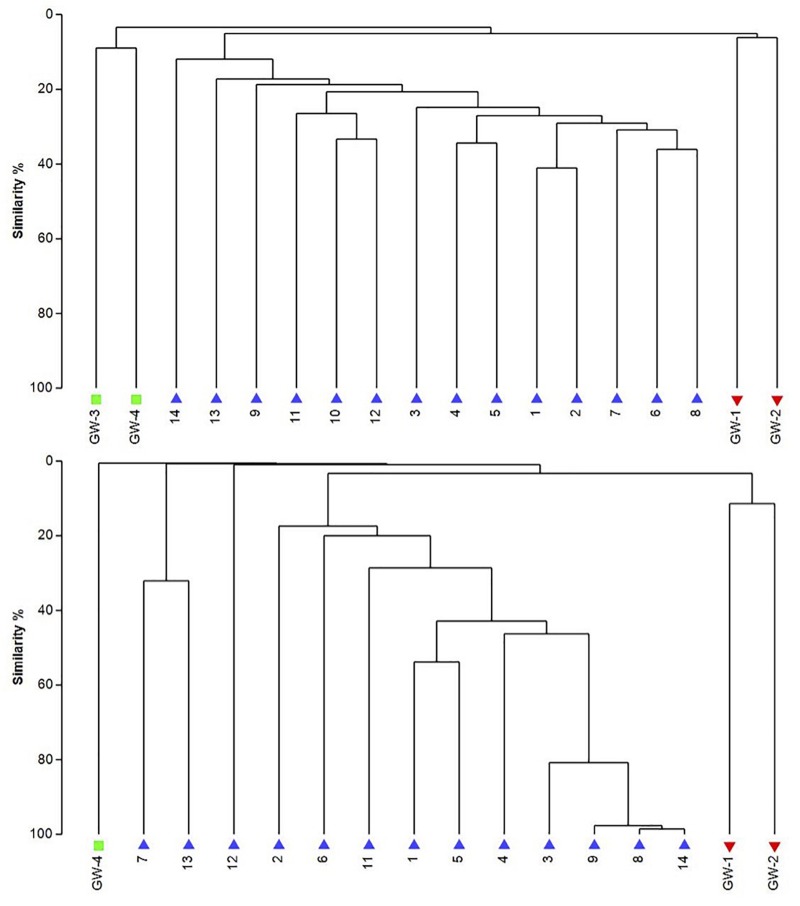
The UPGMA dendrograms of bacteria (top) and archaea (bottom) based on OTU abundance. The blue triangle is for sediment (1 to 14), the red inverted triangle is for playa groundwater (GW-1, GW-2), and the green square is for dune groundwater (GW-3, GW-4).